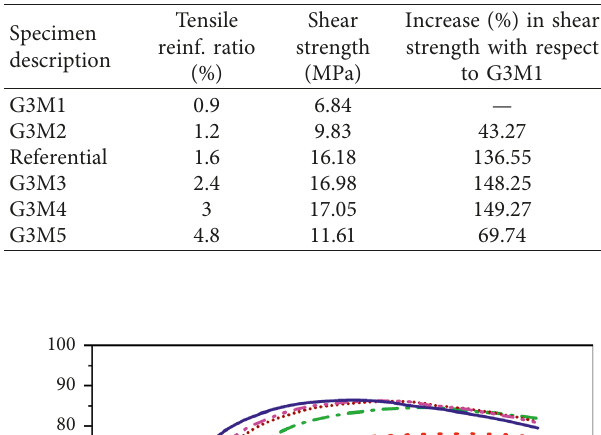
Table 12: Shear strength response of specimens with different tensile reinforcement ratios.